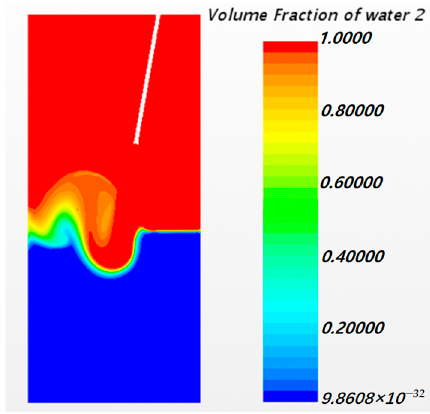
Figure 23. The numerical simulation result of sediment